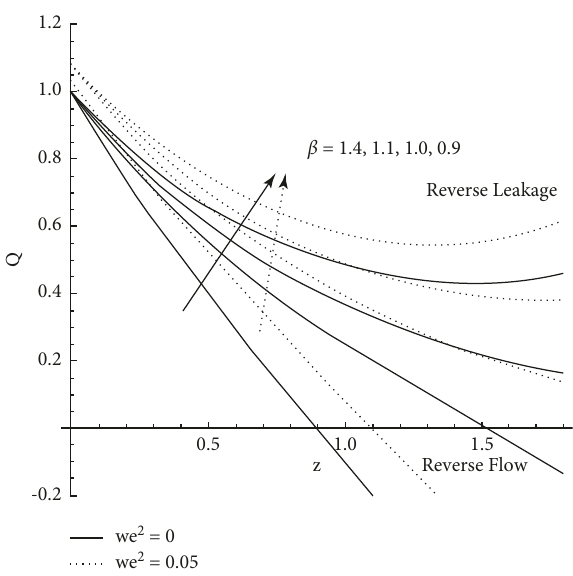
Figure 1: Variation of axial flow rate Q with z for different values of β